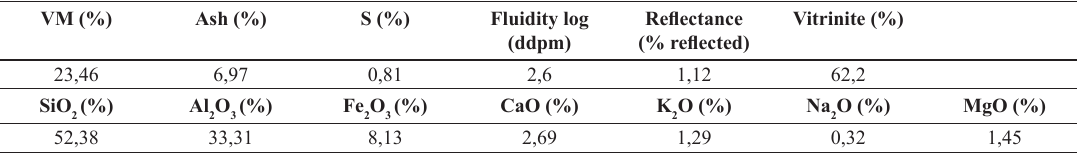
Figure 1. Tire amount sold 2007-201410. Table 2. Physic-chemical characterization of coal based